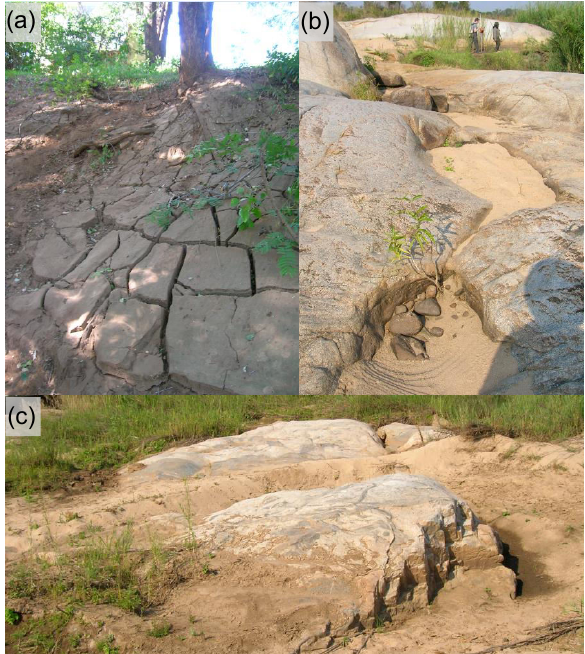
Figure 5. Sediment deposition patterns on the Olifants River in the Kruger National Park: (a) post-flood peak silt drapes (flow direction from left to right); (b) sand accumulation in topographic lows (flow direction from top to bottom); (c) sand deposition in topographic lows and areas in the lee of bedrock outcrop (flow direction from right to left). Silt deposition is also evident in the lee of the outcrop (see foreground), and in the stoss side hollow, possibly owing to reworking from the topographic high by